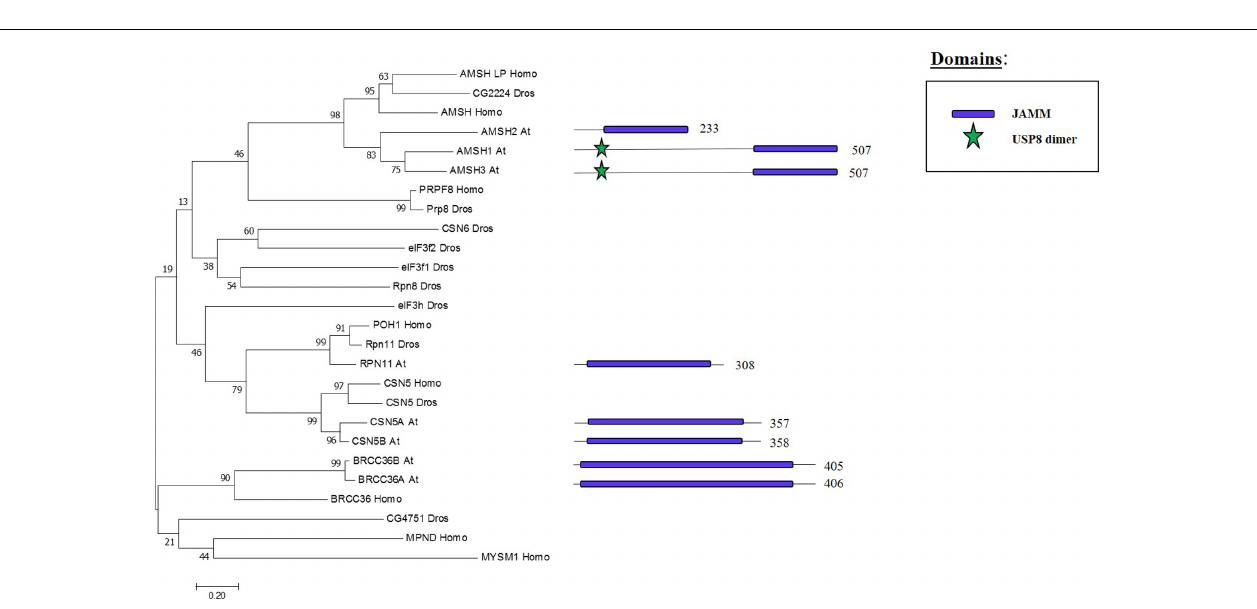
FIGURE 5 | Arabidopsis Josephin family and the high sequence similarity proteins in Humans and Drosophila. Phylogenetic analysis showing the 2 members of the Josephin family based on protein sequence percentage of similarity and their domains. The analysis was conducted in MEGA7 (Kumar et al., 2016). The tree was constructed by the Neighbor-Joining method with bootstrap resampling (5000 replicates). The numbers in the nodes indicate bootstrap values. The distances were computed using the Poisson method. Scale bars indicate units of the number of amino acid substitutions per site. The numbers in the domain representation indicate the amino acids number.